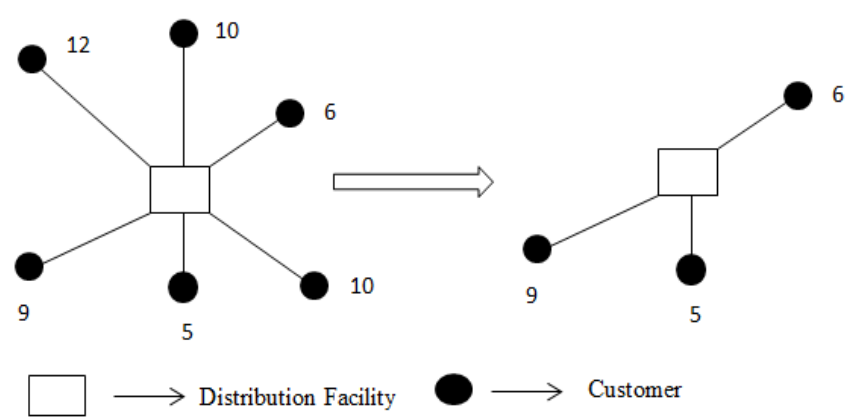
Figure 1. Geometrical illustration of the set covering location problem.